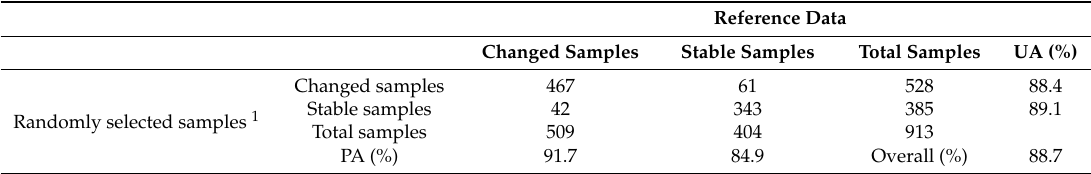
Table 2. Accuracy assessment of change detection in the spatial domain.